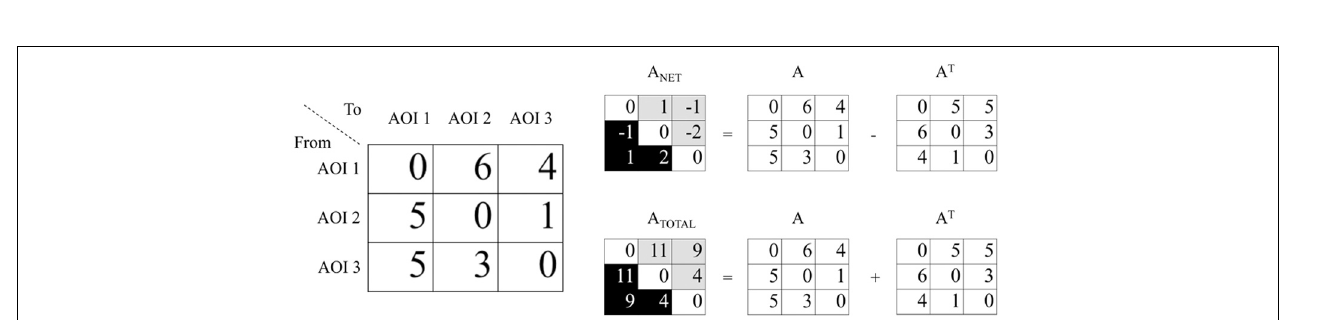
FIGURE 2 | Left panel. Transition matrix: The diagonal contains zeros because by definition a transition is a saccade from one AOI to another. In this example there are 5 transitions from AOI nr 3 to AOI number 1. Right panel . The black cells in A net describe the net transitions. The positive number in the third row,